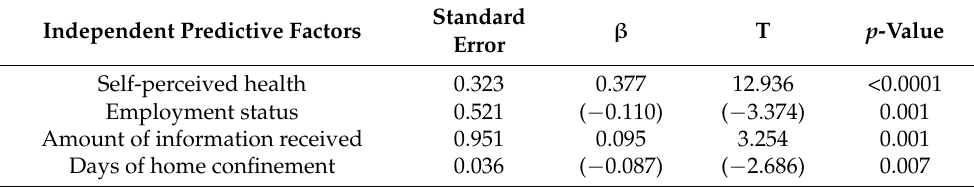
Table 3. Forward stepwise multivariable regression analysis between sociodemographic variables and